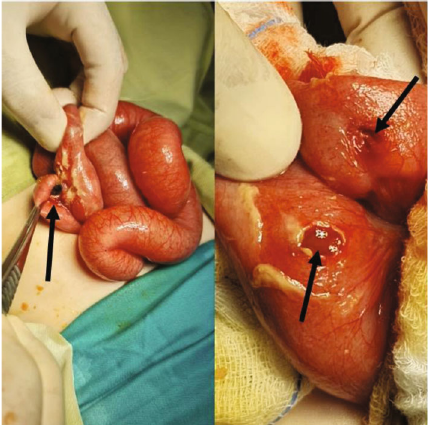
Figure 2: Intestinal perforations (indicated with arrows) as a result of magnet ingestion showing the pus and both